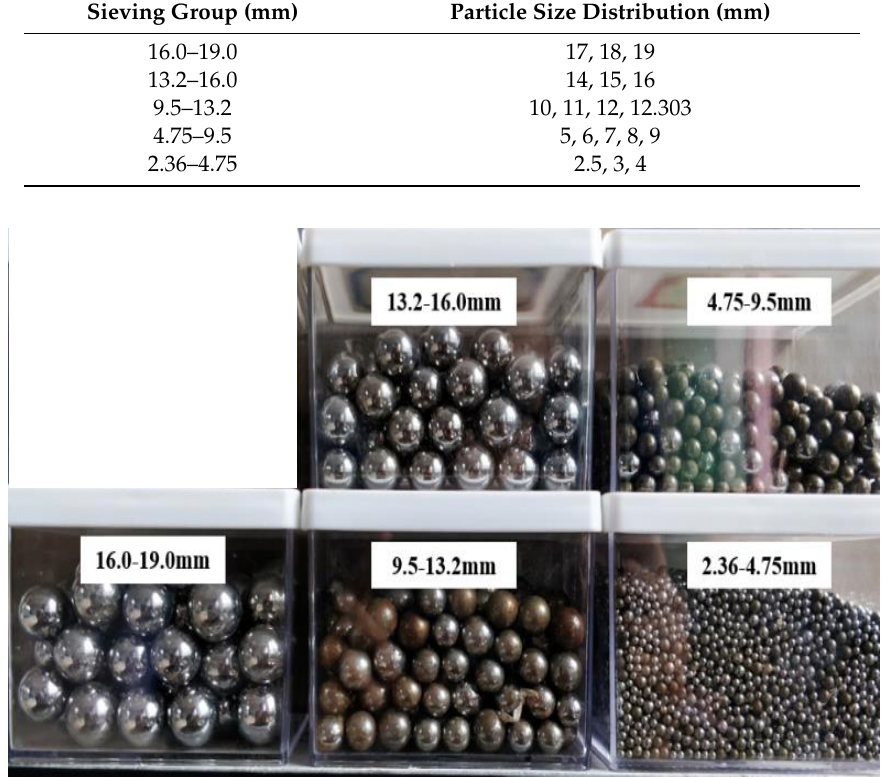
Figure 9. Steel balls with different sizes.